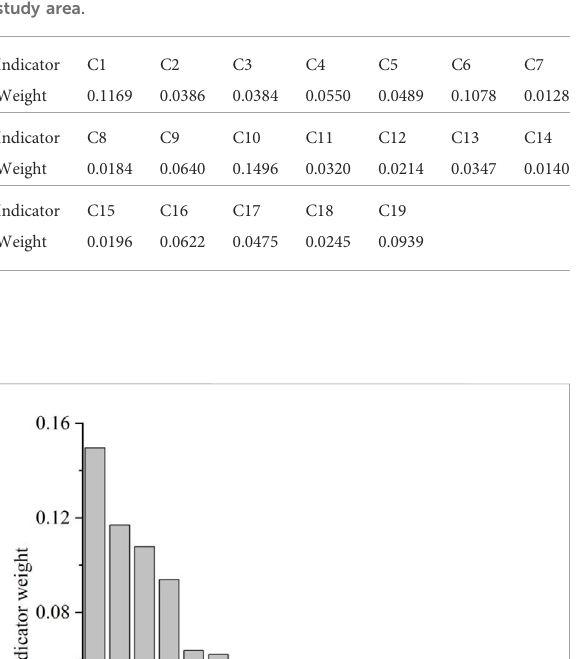
TABLE 2 Weights of the 19 indicators for WRCC evaluation of the study area.